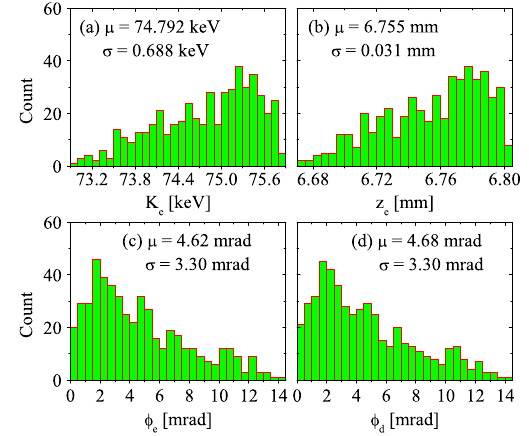
FIG. 4. Exit acceleration statistics of the (cid:2) -particle ensemble: (a) kinetic energy, (b) axial excursion, (c) ejection angle, and (d) deflection angle. Ensemble characteristics, laser beam parame- ters, and the integration time are all the same as in Fig. 2. The symbols (cid:1) and (cid:12) stand for the mean and standard deviation, respectively, of the displayed